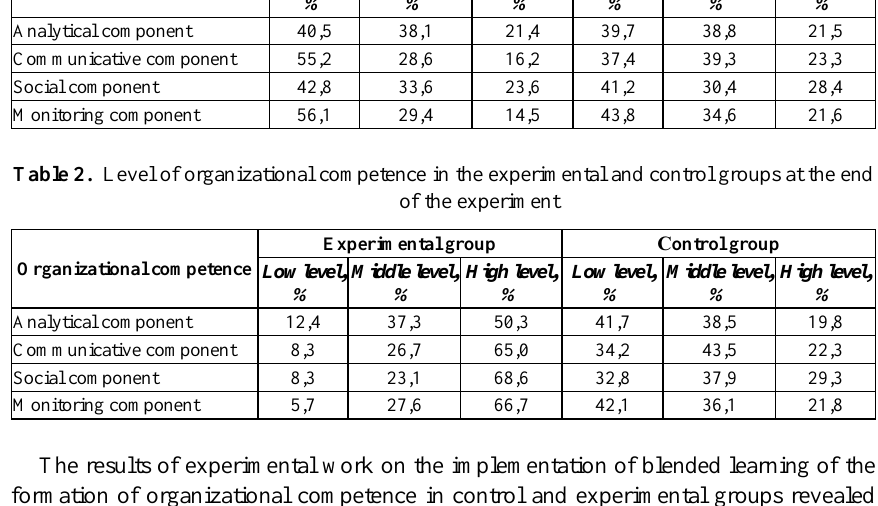
Table 1. Level of organizational competence in the experimental and control groups at the beginning of the experiment Experimental group Organizational competence